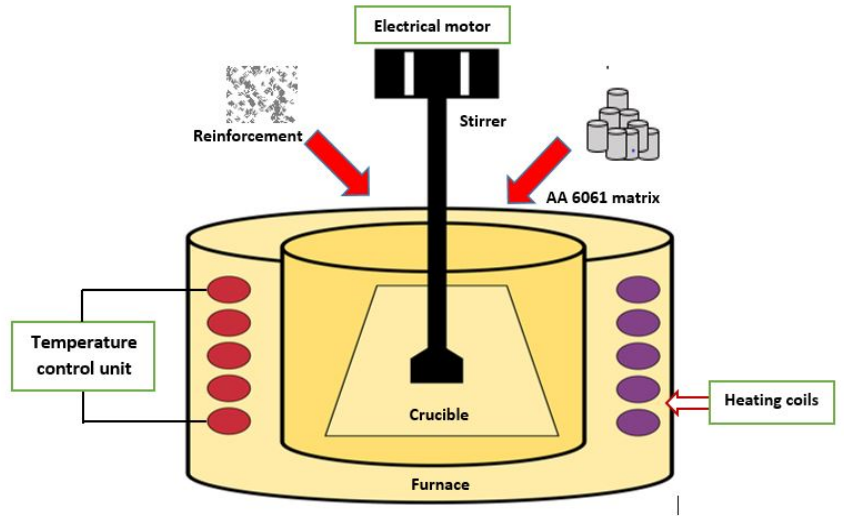
Figure 1. Schematic diagram of stir-casting method of AA 6061 composites